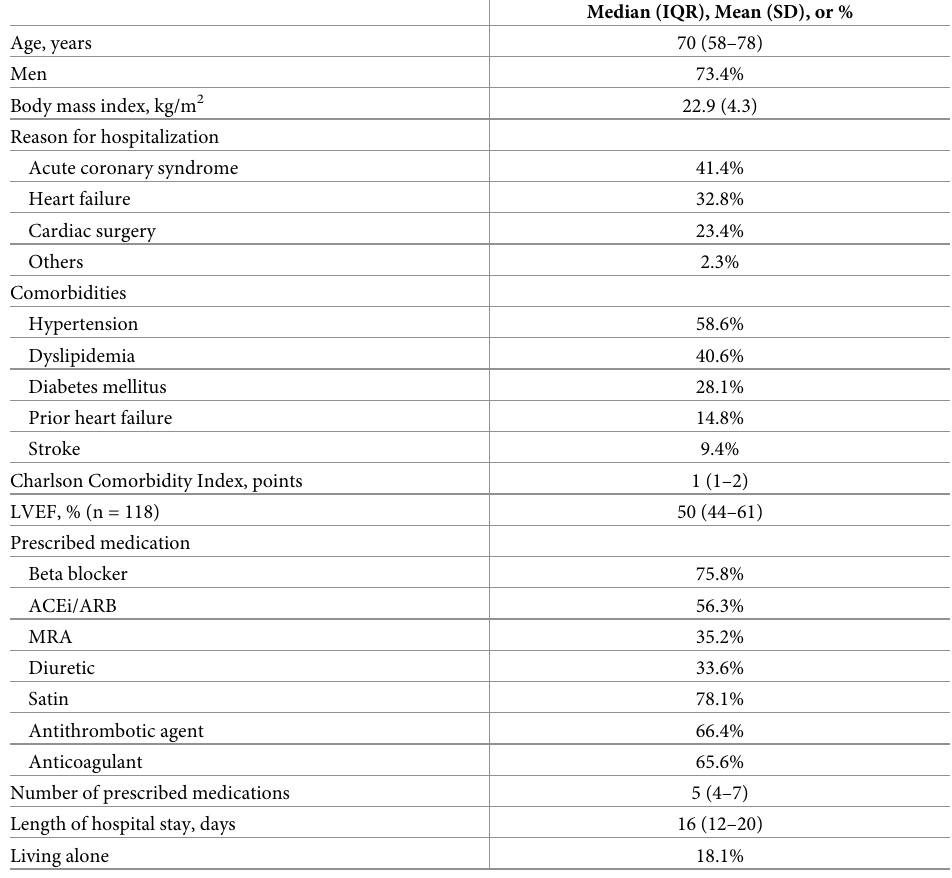
Table 1. Characteristics of the study participants (n =